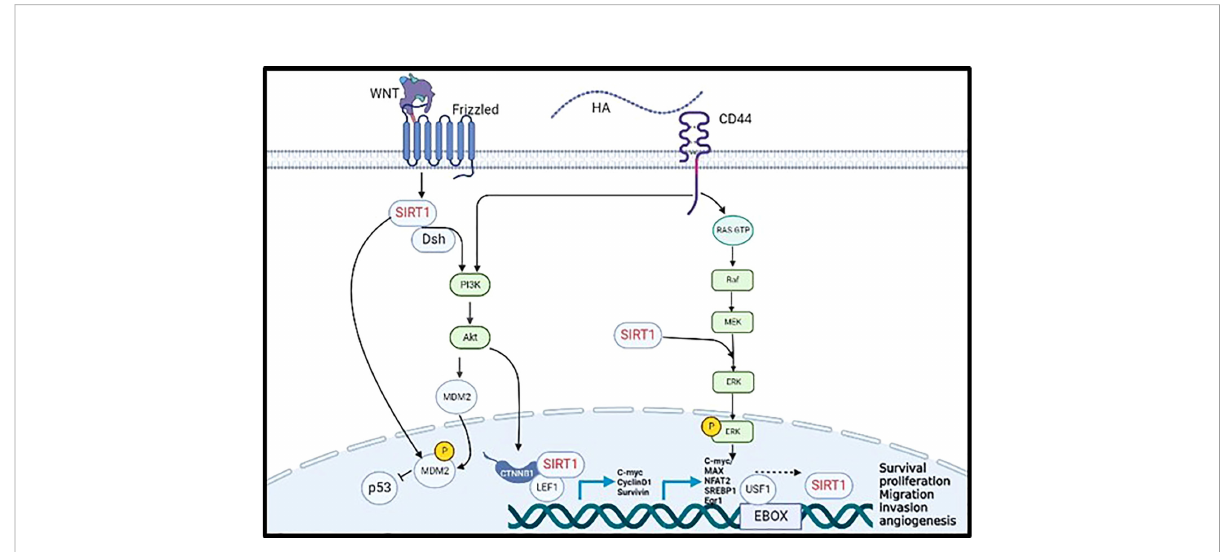
FIGURE 1 Validated ( ! ) and proposed ( – – – ! ) mechanisms linking CD44 activation by hyaluronan to induce SIRT1 transcription promoting tumor cell progression and